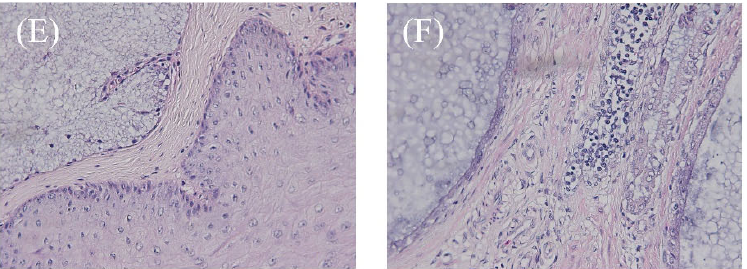
Figure 2. Mucosal papillary proliferation in 27-week-old chickens. ( A ) Irregular, pleomorphic mucosal-gland-like pustules in the esophagus. ( B ) The stratified squamous epithelial cells of the esophagus were completely replaced by increased numbers of ducts/ductules, lymphocytes, and connective tissue, resulting in a papillary morphology (40x). ( C ) Multiple hyperplasia of esophageal gland in the submucosa (40x). ( D ) Degeneration of the epithelial layer, lymphocyte infiltration of the submucosal layer and the ducts surrounded by a fibrous stroma (200x). ( E ) Normal esophageal epithelial cells and esophageal glands (400x). ( F ) The esophageal glands were lined by a single layer of columnar cells, and a large number of lymphocytes infiltrated into the submucosal layer (400x).